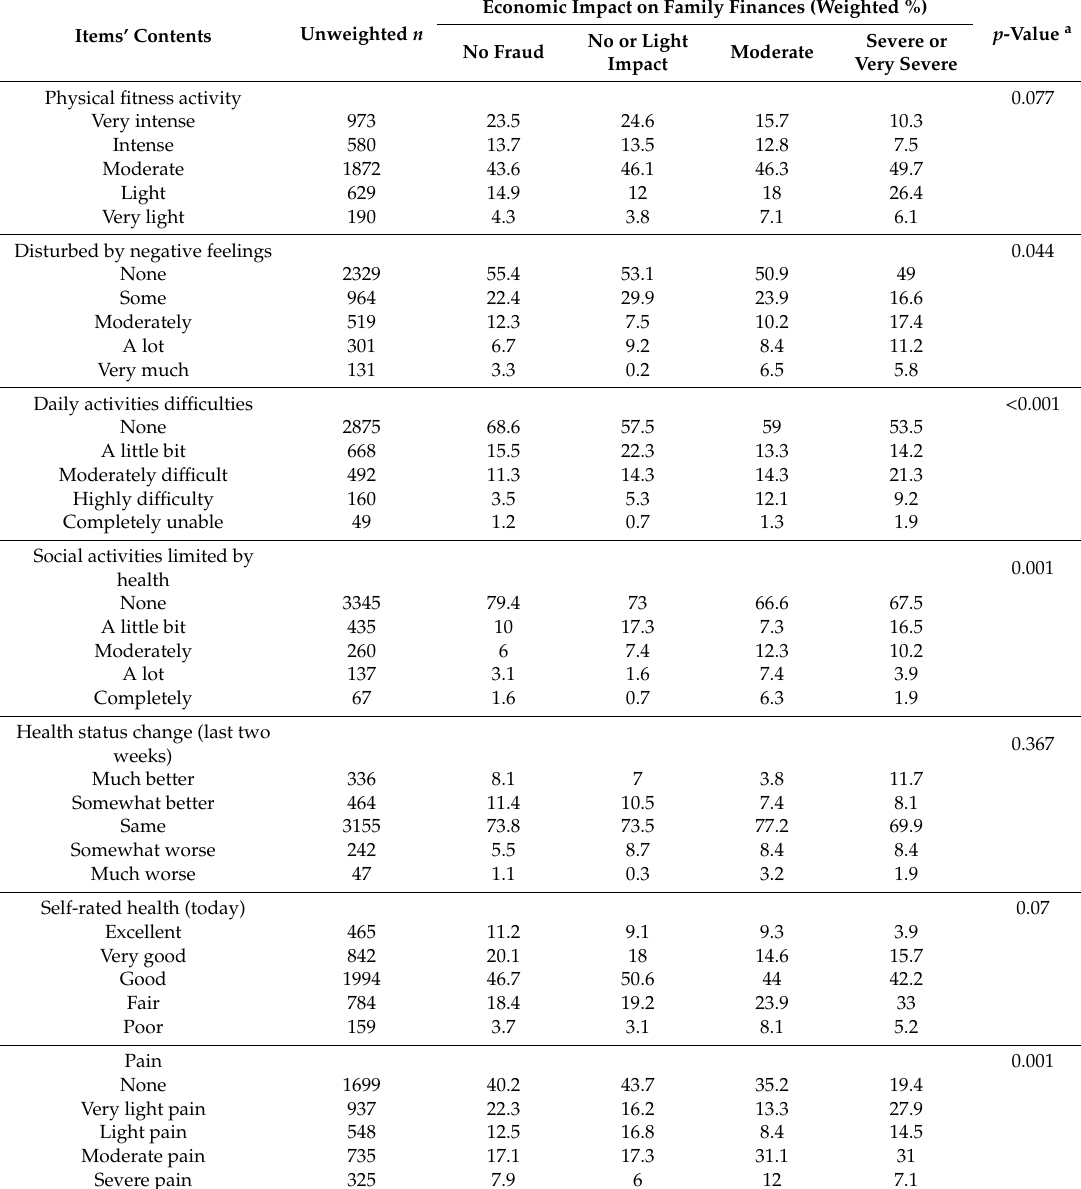
Table 4. WONCA items according to economic impact on family